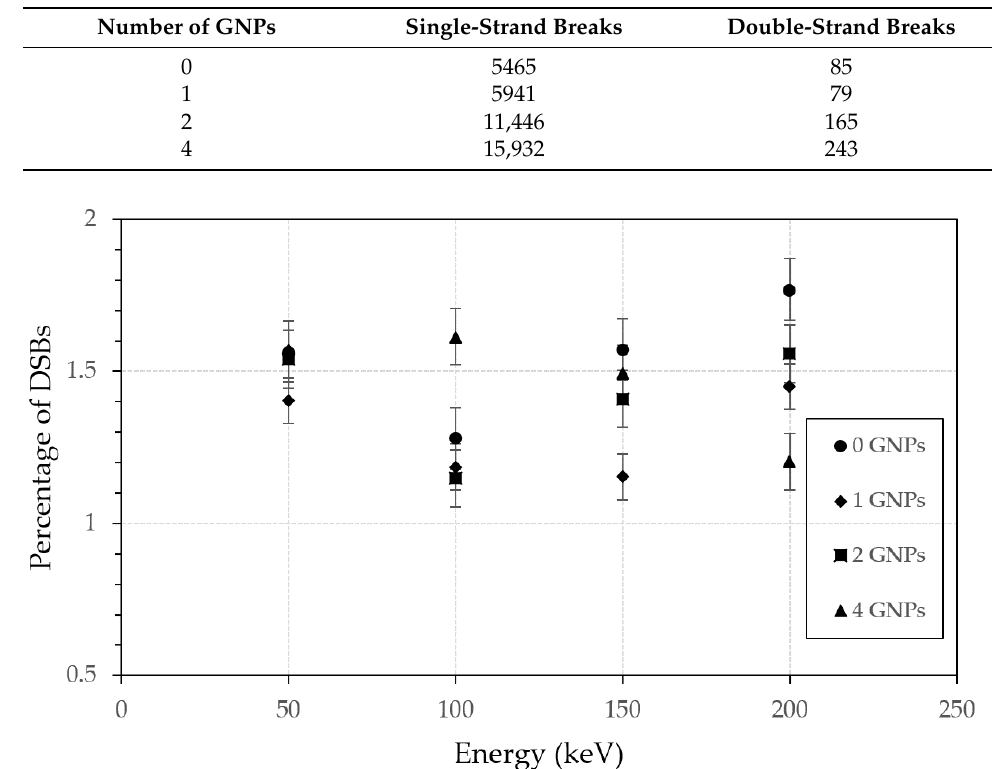
Figure 4. Relationship between the total strand breaks and electron energy (keV) with a depend- ence on the number of GNPs present.